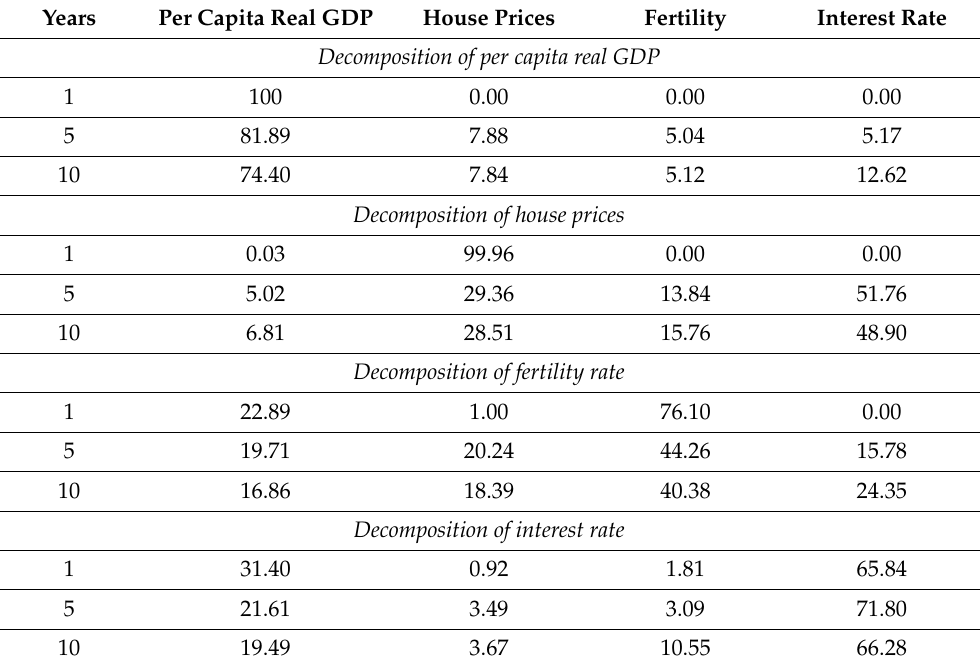
Table 3. Decomposition of variance from the structural VAR.